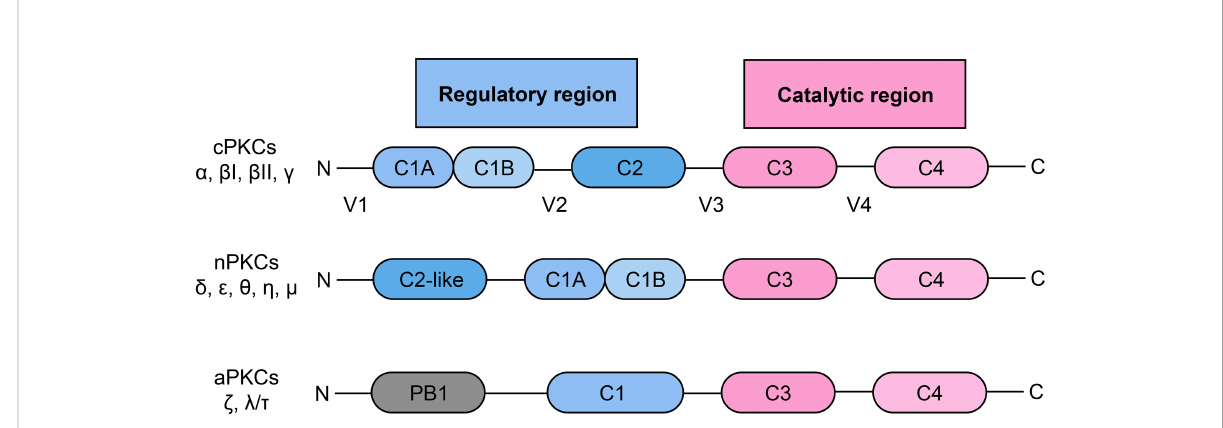
FIGURE 1 Classi fi cation and structural of protein kinase C.PKC: protein kinase C; cPKC: conventional protein kinase C; nPKC: novel protein kinase C; aPKC: atypical protein kinase